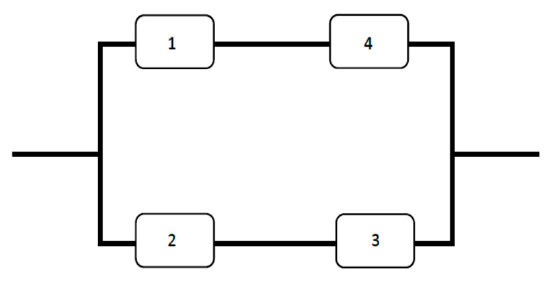
Figure 3. Block diagram of the 2-out-of-4 complex system.